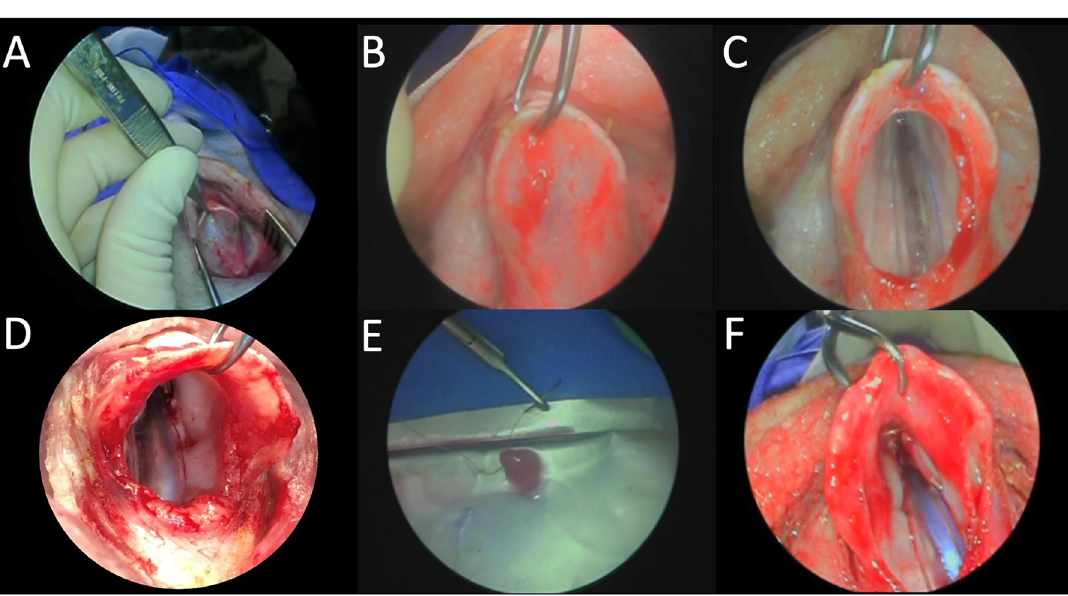
Fig 1. Transcervical COVR implantation in a Yucatan mini-pig. A) Retracting the vertical midline incision allows B) elevation of thyroid cartilage. C) Incision of thyrohyoid membrane exposes endotracheal tube. D) View of right vocal fold after resection of epithelium and lamina propria. E) Suture passage through COVR implant. F) Bilateral vocal fold COVR implants in place. https://doi.org/10.1371/journal.pone.0284135.g001 reaction. Pig 1 was treated with this protocol after receiving cell injection. Pig 2 did not receive human cells, and in consultation with the veterinarian cyclosporine was withheld to avoid drug-related comorbidities. Prednisone was continued in pig 2 for consistency with other ani- mals because of its potential influence on vocal fold wound healing. Pig 3 did receive both cyclosporine and prednisolone but developed a fatal meningitic infection under this immuno- suppressant protocol. Therefore, pigs 4–7 were given milder immunosuppression with pred- nisolone alone. Pig 7 subsequently fell ill due to an endemic porcine bacterial infection but survived to planned euthanasia. To avoid further infectious complications, pig 8 was treated with only 3 days of perioperative dexamethasone without long-term immunosuppression or corticosteroids. Table 1 summarizes the animal treatments.